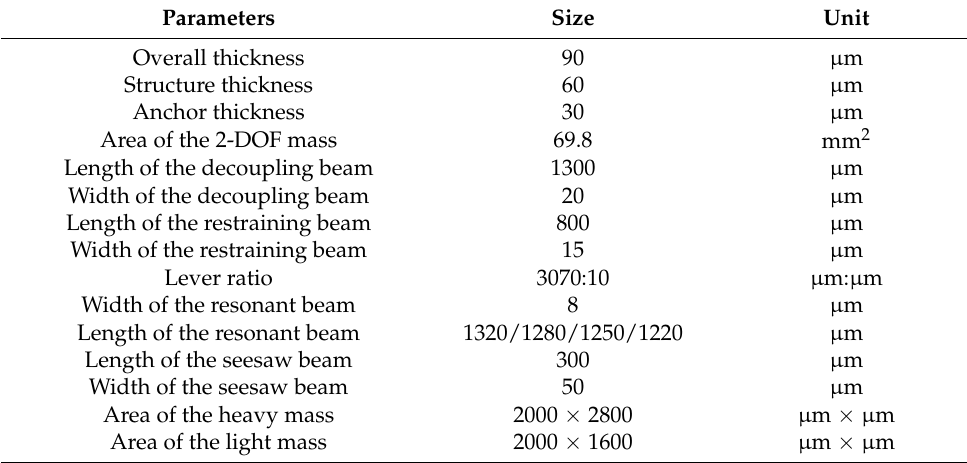
Table 1. Structure parameter of the tri-axis accelerometer. Parameters Size Unit Overall